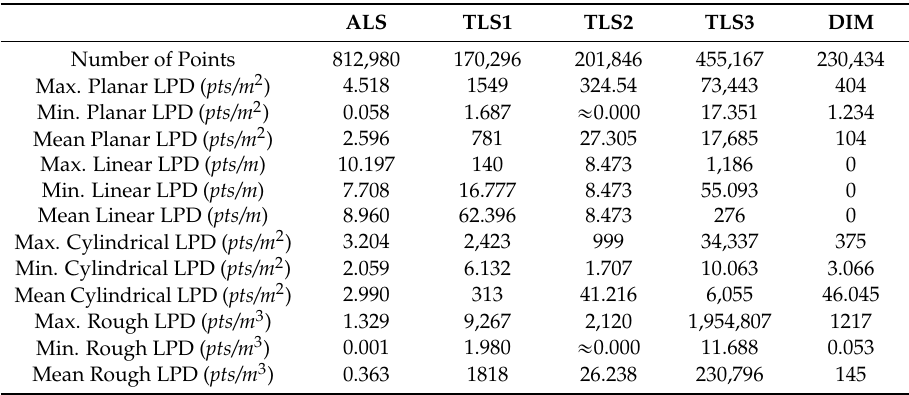
Table 1. LPD statistics for the different